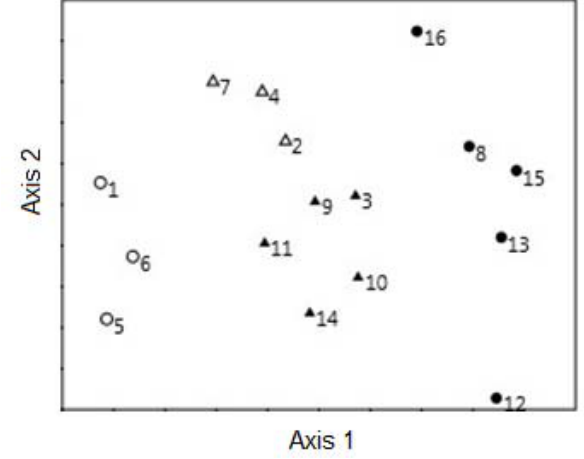
Figure 1. Non-metric multidimensional scaling ordination for sixteen study sites. The analysis was based on the twelve stand structural variables attributed to old-growth.